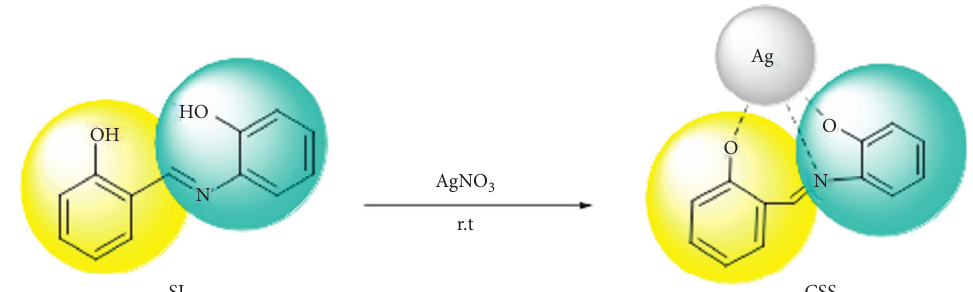
Scheme 3: Chemical reaction of Schiff base complex